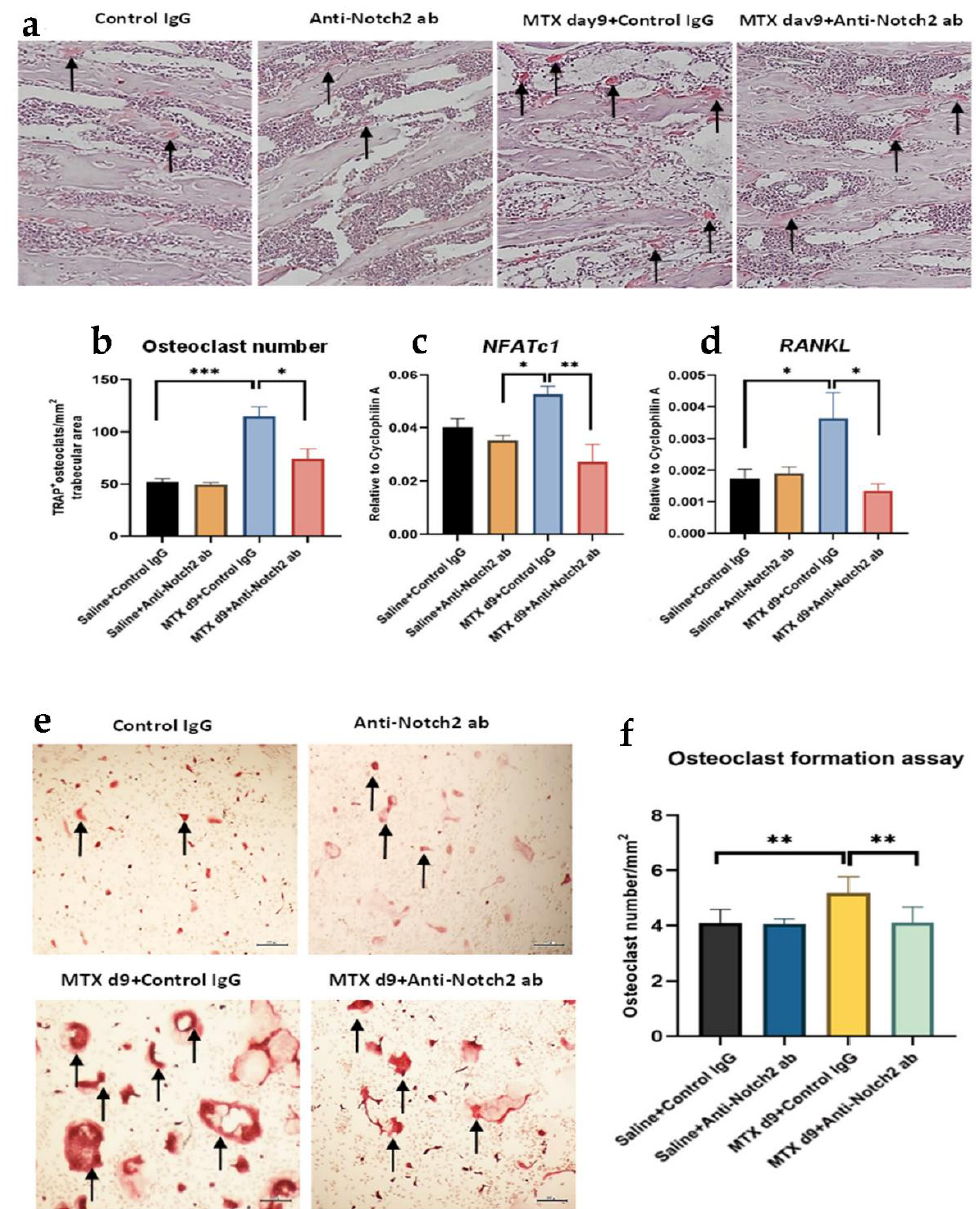
Figure 4. Treatment effects on osteoclast density, expression of regulatory genes and osteoclastogenic potential of non-adherent bone marrow cells isolated from rat bones. ( a ) Representative bone section images of different treatment groups with arrows pointing TRAP-stained multinucleated osteoclasts in the secondary spongiosa area; ( b ) osteoclast density at different treatment groups; treatment effects on ( c ) NFATc1 and ( d ) RANKL mRNA expression. ( e ) Representative images of osteoclast formation assays conducted for different group of rats, with TRAP-stained multinuclear osteoclasts being indicated by arrows; scale bar is 200 µm. ( f ) The graph indicates osteoclast formation potentials of different groups expressed as number of TRAP + osteoclasts/mm2 culture area; * p < 0.05, ** p < 0.01, *** p < 0.001.